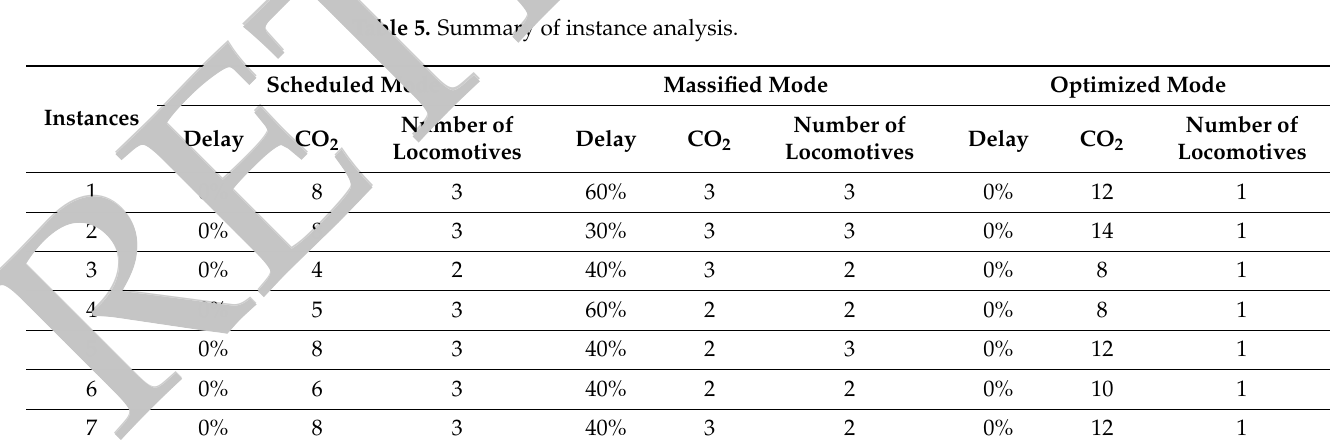
Figure 10. Circulation in planned transfer mode. Table 5. Summary of instance